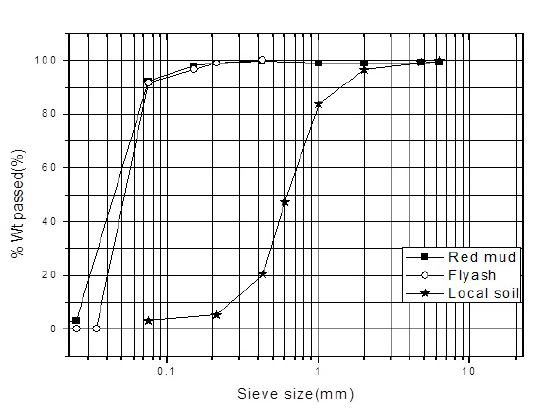
Figure 4. Grain size distribution curves of red mud with fly ash and local soil